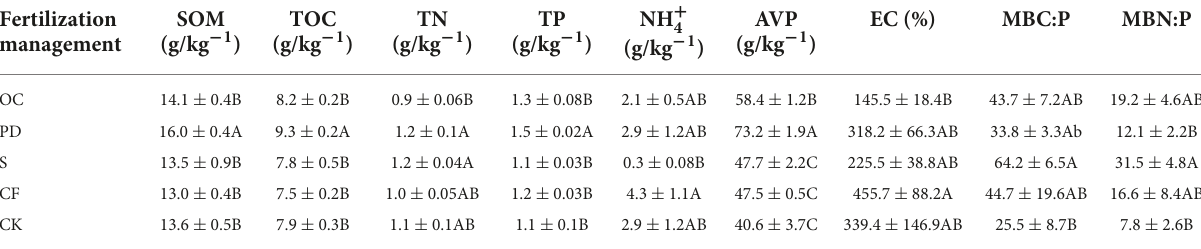
TABLE 2 Effects of different fertilization management on soil organic matter, soil and microbial carbon, nitrogen and phosphorus after 12-year tobacco-maize rotation. Fertilization management